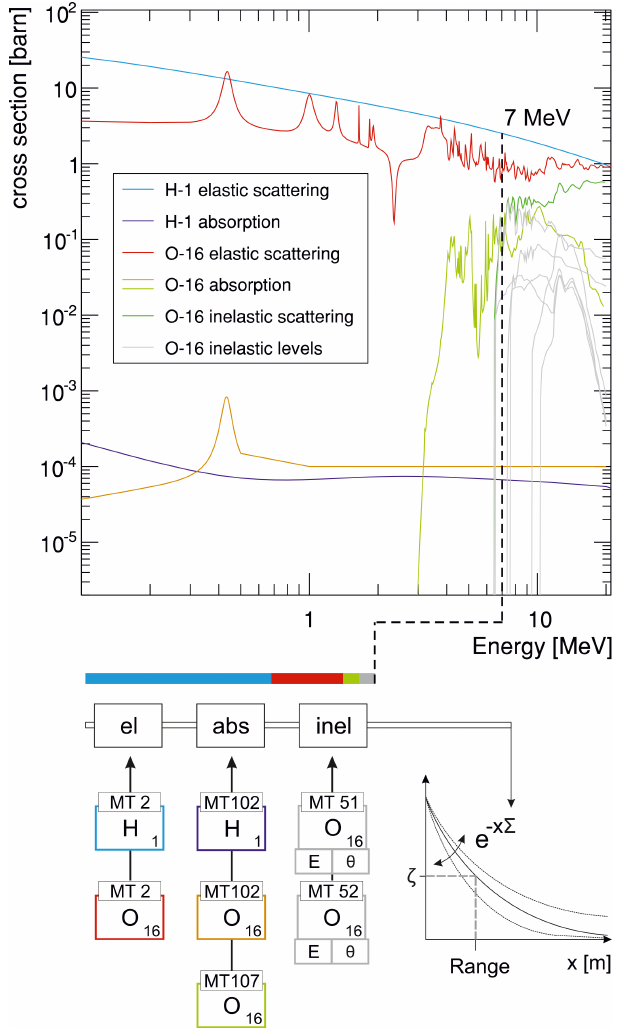
Figure 8. Range calculation in URANOS is as follows: for a given neutron energy, here in the MeV range, the cross sections from the isotope list are evaluated according to elastic, inelastic and absorp- tion processes. Only possibly relevant contributions are evaluated. The left panel shows such a list of reaction probabilities for water. Inelastic levels are only displayed up to MT56 and are linked ad- ditionally to energy loss and angular distribution. The cross section multiplied by the atom number density in Eq. (29) yields the macro- scopic cross section. By sampling a random number ξ as in Eq. (5), a free path length value for the range (4) is